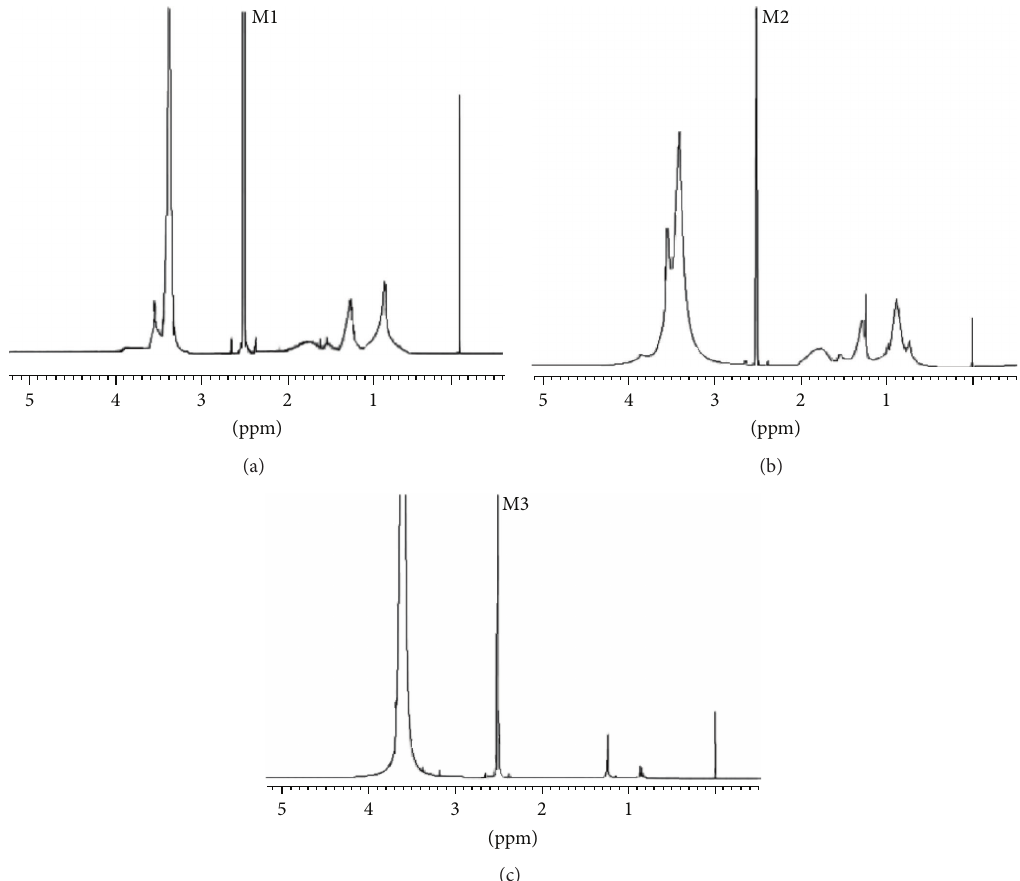
Figure 2: 1 H NMR of the prepared terpolymers M1, M2, and M3 in DMSO-D 6 .